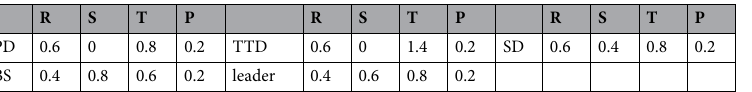
Table 2. Games and their payoffs. R is the payoff to mutual cooperation, T payoff to defection against a cooperator, S payoff to cooperation with a defector, and P the payoff of mutual